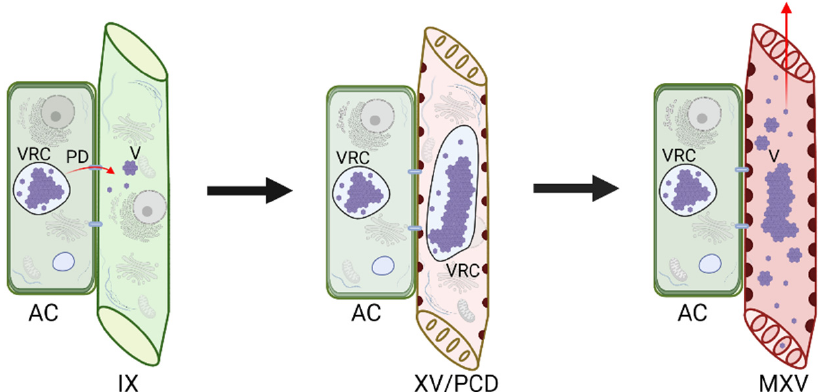
Figure 2. A model depicts how viruses enter immature xylem cells via cell-to-cell transfer from an adjacent cell. This model consists of three main stages: (1) Viruses enter the immature xylem cells, which still have the cellular machinery, via the plasmodesmata; (2) Viruses complete the replication and assembly cycle before the immature xylem cells undergo programmed cell death; (3) As the xylem vessels mature and the cell wall thickens, the cellular contents are released, and with that, the viruses are released into the xylem translocation stream for further spread. The red arrows point to potential virus movement routes. PD: plasmodesmata; VRC: viral replication complex; V: virus arrays; AC: adjacent cell; IX: immature xylem cells; XV/PCD: xylem vessels undergoing programmed cell death; MXV: matured xylem vessels. Figure was generated with Biorender.com.